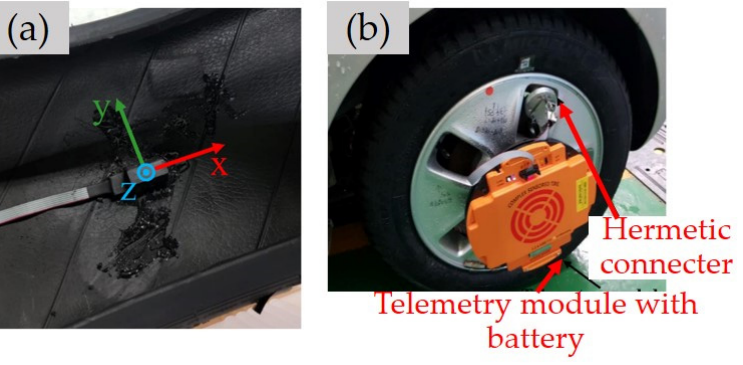
Figure 12. Example of an intelligent tire system setup and its installation parts: ( a ) accelerometer and ( b ) additional equipment components [86].